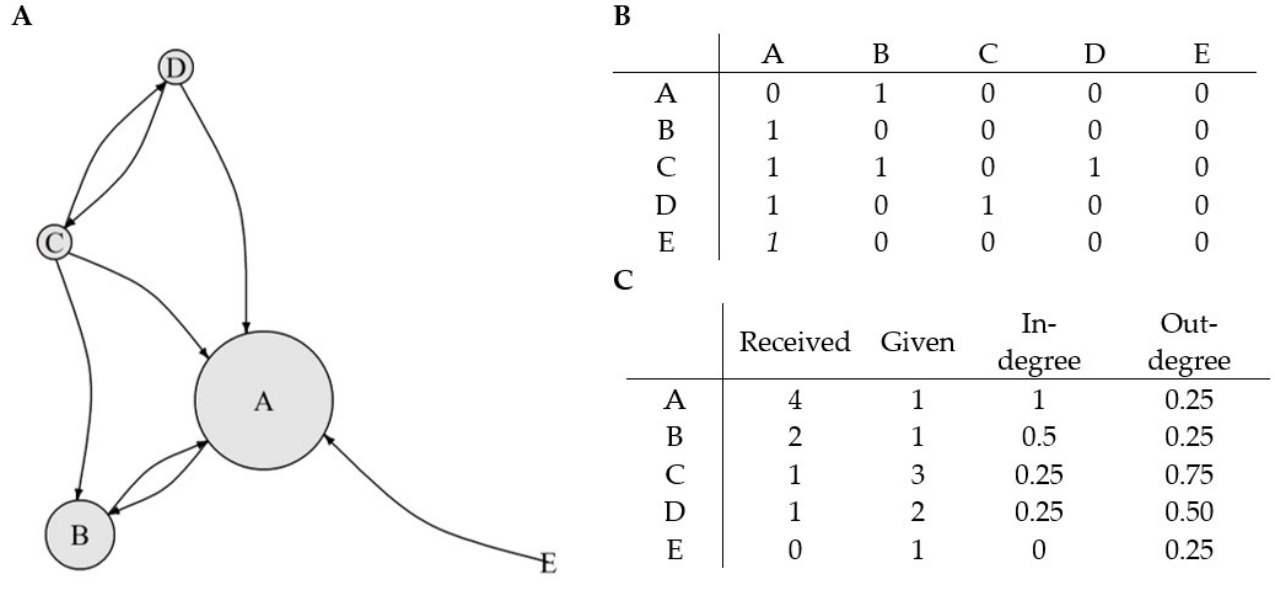
Figure 1. Example of calculation of in-degree and out-degree measures. ( A ) Assumed network; ( B ) adjacency matrix of the network; ( C ) the number of received and given nominations and the values of in-degree and out-degree measures for students in the network.